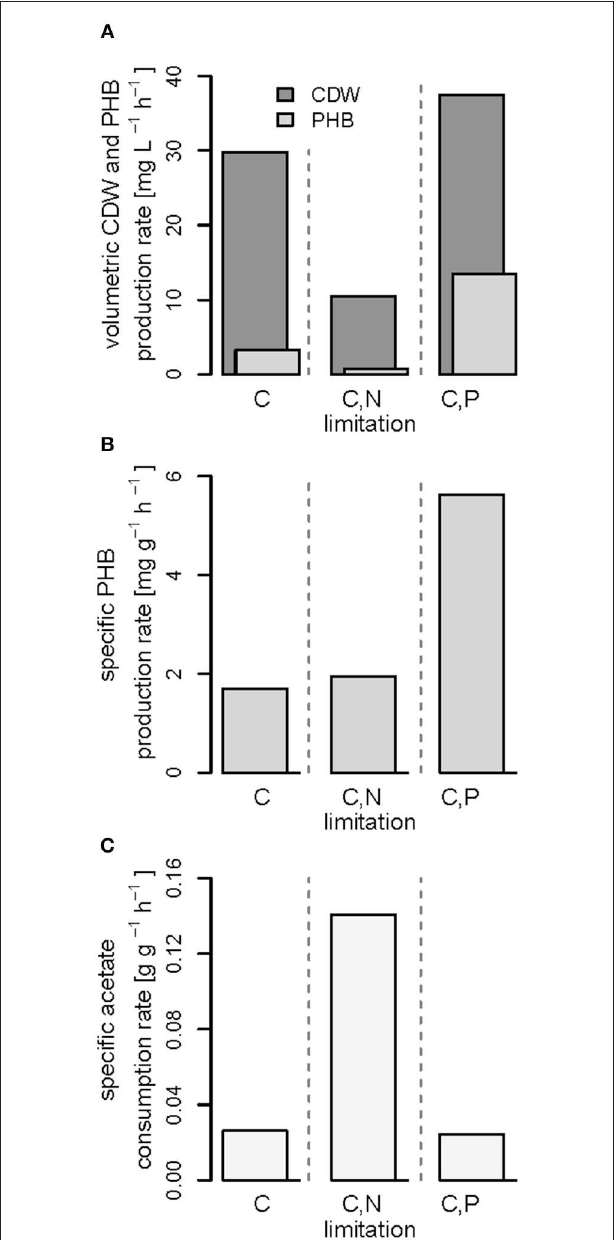
FIGURE 7 | Productivities and acetate consumption rate in the (multiple) nutrient-limited growth phases. Comparison of data obtained from fed-batches with R. rubrum with continuous syngas and acetate feeding in the phases (iii) shown in Figures 3 – 5 . (A) Volumetric productivities of cell dry weight (CDW) and PHB, (B) specific PHB production rate, and (C) specific acetate consumption rate.